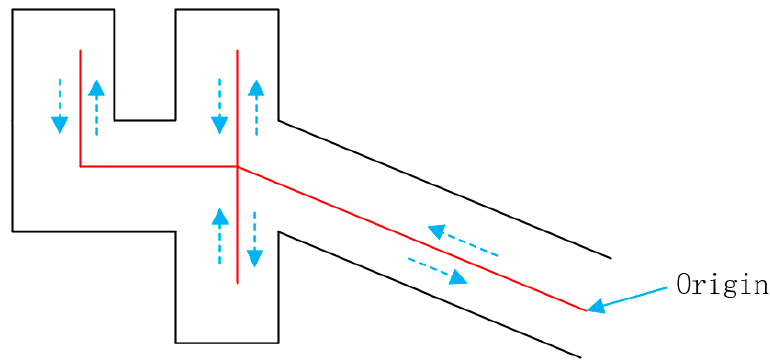
Figure 6. Reference track diagram in the building environment. Table 2. Localization MSEs of soldiers using different algorithms in a building environment experiment.